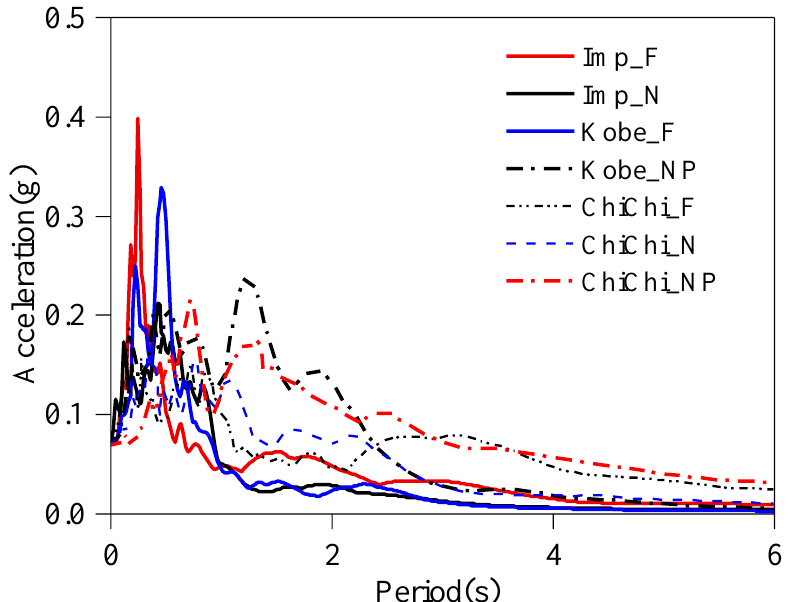
Figure 3. History of acceleration of the earthquake ground motions: ( a ) Imp_F; ( b ) Chihi_F; ( c )